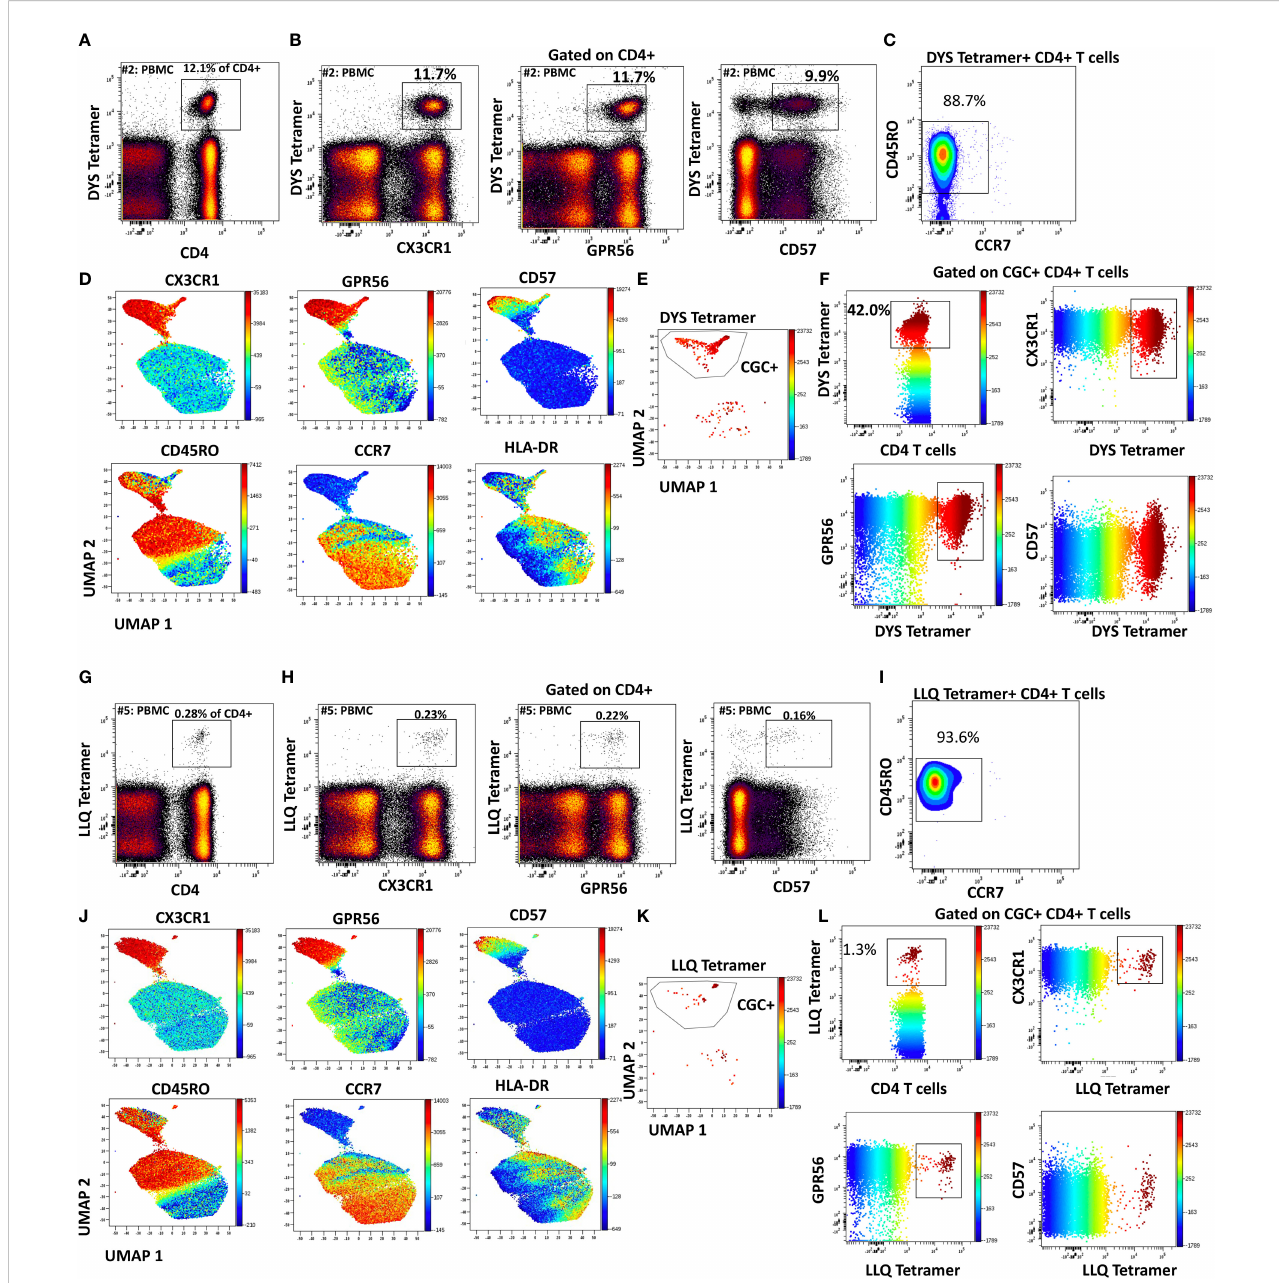
FIGURE 4 CMV-speci fi c CD4 + T cells are predominantly CGC + . Phenotypic expression of CX3CR1, GPR56, and CD57 by CMV-speci fi c CD4 + T cells that recognize two different epitopes (DYS and LLQ). Peripheral blood DYS-speci fi c CD4 T cells as a proportion of CD3+ T cells (A) . Two-dimensional plots show the co-expression of CX3CR1, GPR56, and CD57 by DYS-speci fi c CD4 T cells (B) . Memory cell phenotypes were classi fi ed as TEM (CD45RO + CCR7 - ) and TEMRA (CD45RO- CCR7-) (C) . UMAP of CD4 + T cells showing the CD4 + T cells with DYS tetramers among the CGC cells. Each panel shows the distribution of CX3CR1, GPR56, CD57, CD45RO, CCR7, and HLA-DR expression on the clusters (D-F) . A second participant with LLQ-speci fi c CD4 + T cells is shown (G-L)